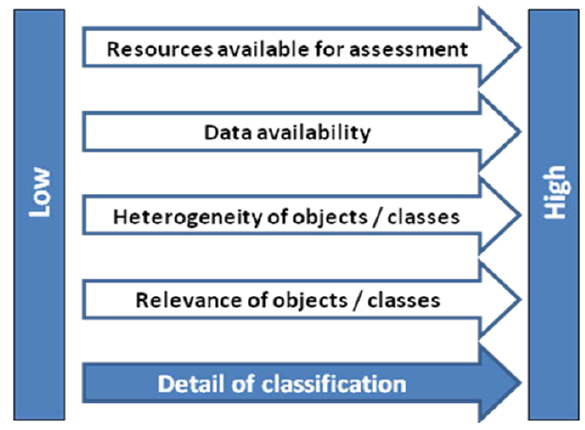
Fig. 1. Detail of classification in flood damage assessments in rela- tion to the main influencing